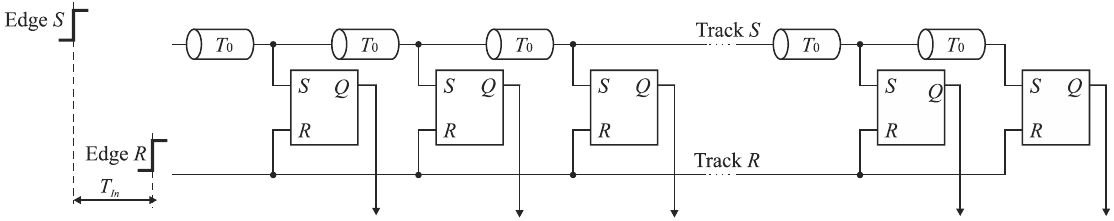
Figure 4. Diagram of time coding delay line TDC.